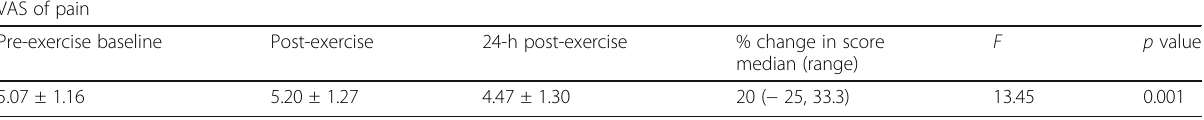
Table 2 Pain score (VAS) before and after exercise VAS of pain Pre-exercise baseline Post-exercise